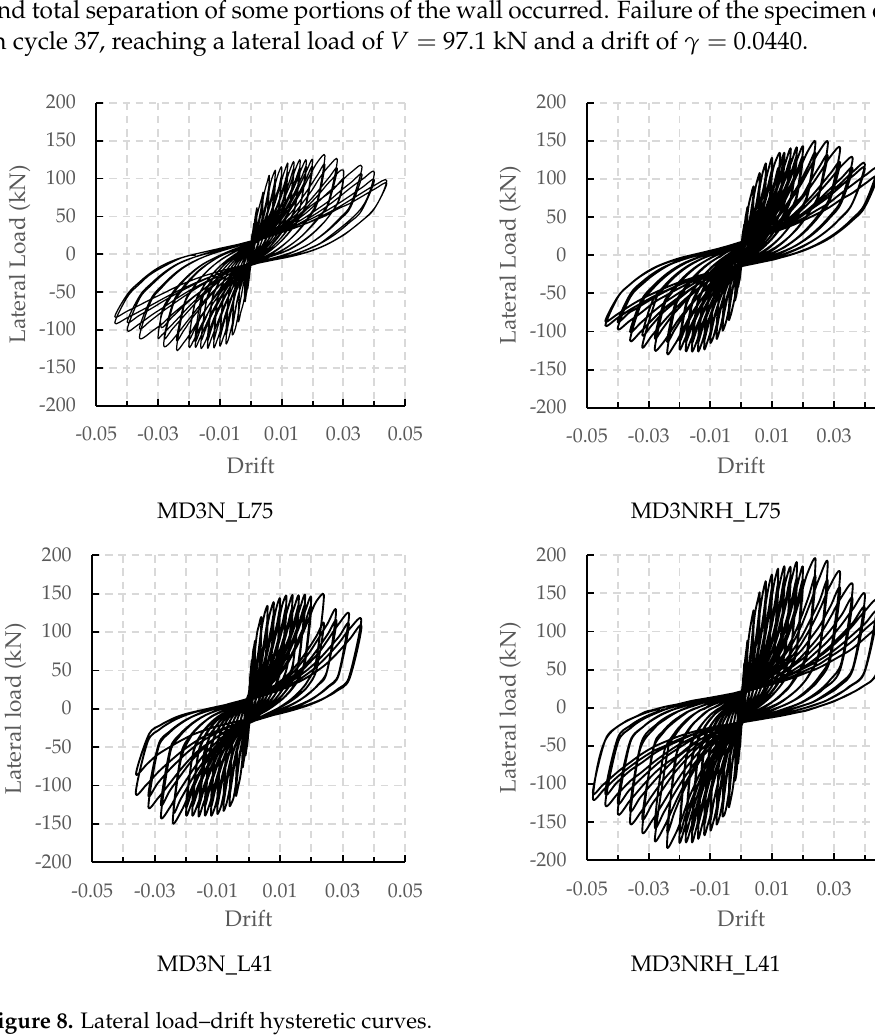
Table 3. Residual drift after unloading and reloading/loading ratio.